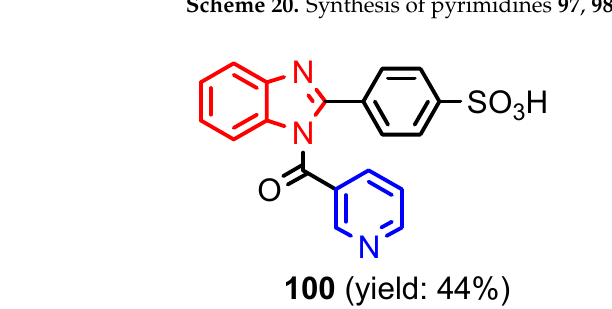
Scheme 20. Synthesis of pyrimidines 97 , 98 and 99 [45].